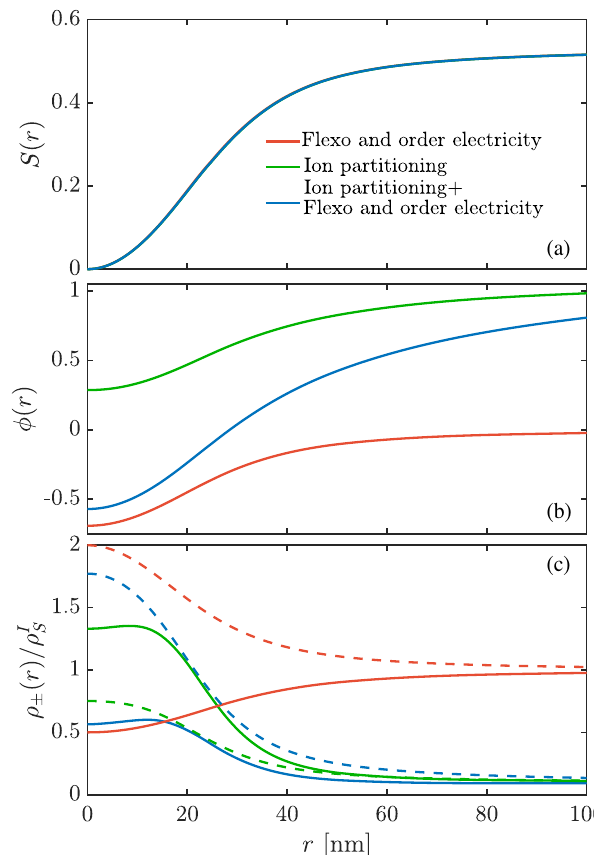
FIG. 3. Electric double layer of a radial þ 1 nematic topological point defect. We show the effect of flexoelectricity and order electricity, and ion partitioning on (a) the order parameter profile S ð z Þ , (b) the dimensionless electrostatic potential ϕ ð z Þ , and FIG. 4. Total charge number N in the isotropic core of a (c) the ion densities for anions ρ − ð r Þ (solid lines) and cations ρ radial hedgehog defect for varying values of the flexoelectric ð r Þ (dashed lines). In all plots, we use κ − 1 ¼ 10 nm, which þ I or order-electric coefficient G as a function of the isotropic results in a bulk ion density in the isotropic phase ρ I 1 . 1 × 10 − 4 M. When order electricity and flexoelectricity Debye screening length κ − 1 . Panel (a) corresponds to a s ¼ I regime with no ion partitioning, g G ¼ 3 pC m − 1 , and when ion partitioning ¼ g − ¼ 0 , and panel are included, we use q þ e (b) corresponds to one with ion partitioning, g ¼ 3 and is included, we use g ¼ 3 and g − ¼ 8 . The system size is taken þ þ g − ¼ 8 . The system size is 250 nm. to be R ¼ 250